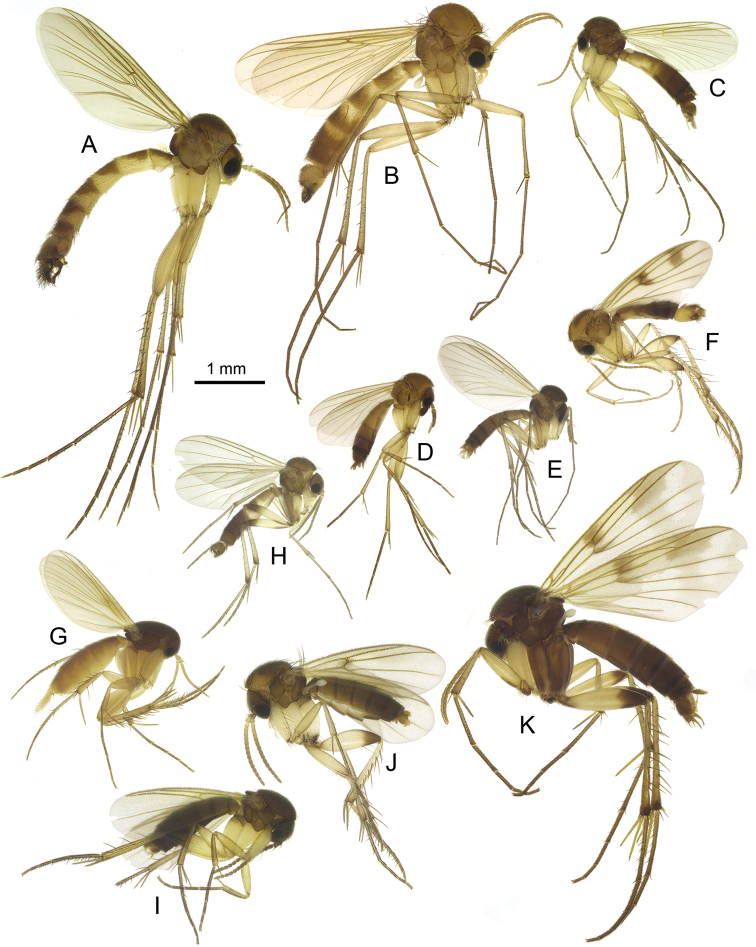
Habitus of Georgian fungus gnats of the family MycetophilidaeAAllodiopsis
domestica (Meigen, 1830) BRymosia
affinis Winnertz, 1863 CBrevicornu
griseicolle (Staeger, 1840) DCordyla
fissa Edwards, 1925 EAnatella
longisetosa Dziedzicki, 1923 FMycetophila
magnicauda Strobl, 1895 GEpicypta
scatophora (Perris, 1849) HPhronia
tenuis Winnertz, 1863 ISceptonia
tenuis Edwards, 1925 JZygomyia
humeralis (Wiedemann, 1817) KDynatosoma
reciprocum (Walker, 1848).